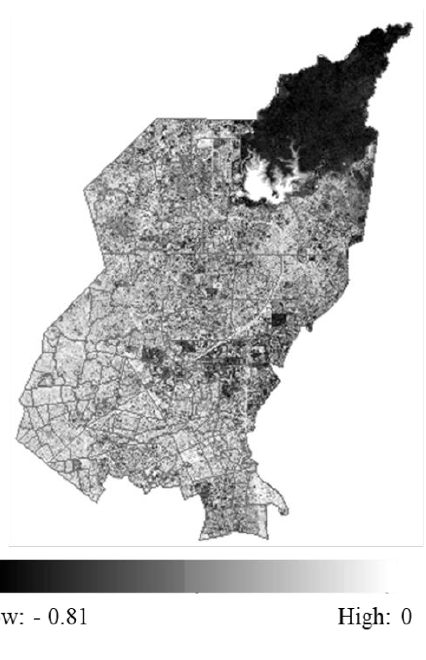
Figure 5. Soil-adjusted vegetation index derived from PlanetScope image of Quezon City